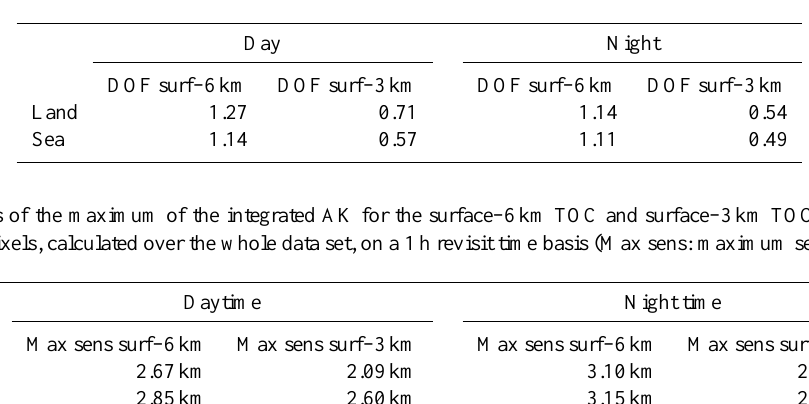
Table 2. Mean DOFs for surface–6km and surface–3km for land/day, land/night, sea/day and sea/night pixels, calculated over the whole data set, on a 1h revisit time basis.